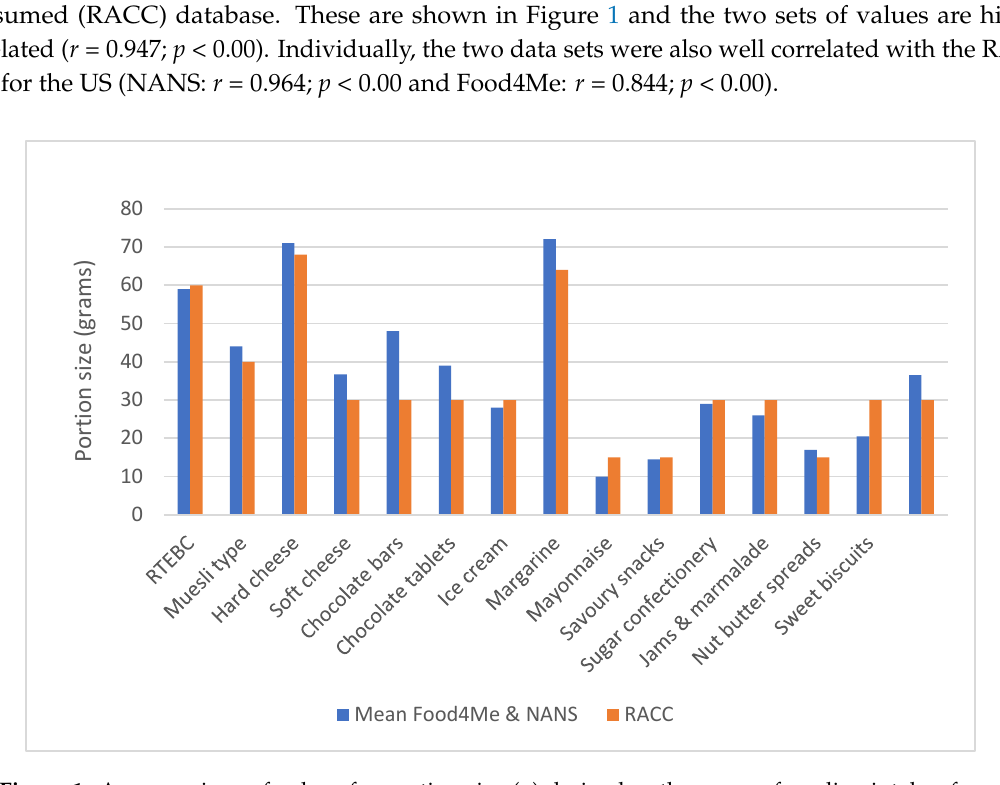
Figure 1. A comparison of values for portion size (g) derived as the mean of median intakes from Food4Me and NANS studies and those from the US Recognised as Customarily Consumed (RACC) database for the 15 food categories chosen in the study.